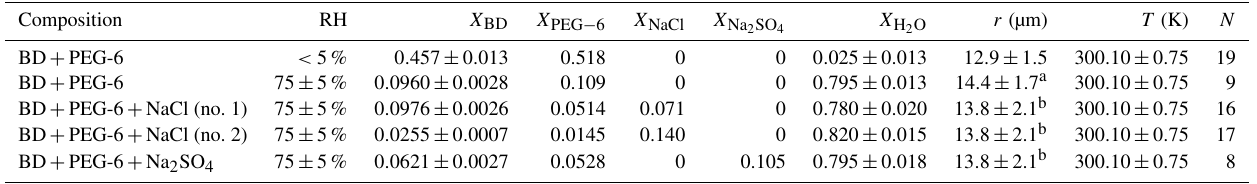
Table 1. Parameters describing the experimental conditions used in each experiment type. These parameters and associated uncertainties were used as model inputs. Relative molar quantities of butenedial, PEG-6, and the inorganic salts were determined via the mass composition of the prepared precursor solution. The overall mole fraction of water was calculated from the experimental relative humidity (75 ± 5% for the humid experiments and 2 . 5 ± 2 . 5% for the dry experiments) and the solution composition via the thermodynamic model AIOMFAC (see body text). Radius measurements were obtained via a spring point technique (see body text). Provided uncertainties are 1 σ values and incorporated into the model calculations as explained in the main